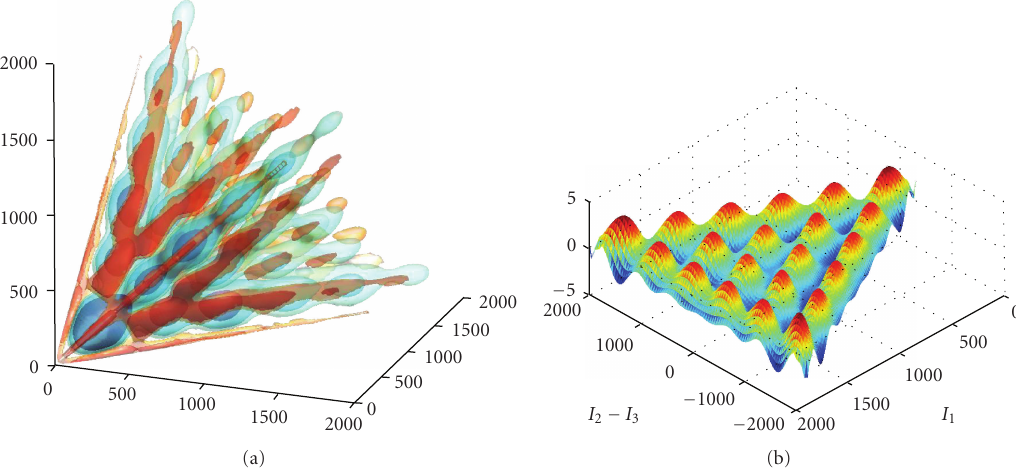
Figure 7: The reduced CMB bispectrum for the constant model b const normalized relative to the large-angle constant solution (48). On (a), (cid:9) 1 (cid:9) 2 (cid:9) 3 the bispectrum is plotted over the allowed tetrahedral region (see Figure 2) using several density contours (light blue positive and magenta negative) out to (cid:9) i ≤ 2000 and, on (b), transverse triangular slices are shown at (cid:9) 1 + (cid:9) 2 + (cid:9) 3 = 2000. Note the coherent pattern of acoustic peaks induced by the transfer functions, from the study by Fergusson et al. in [14].